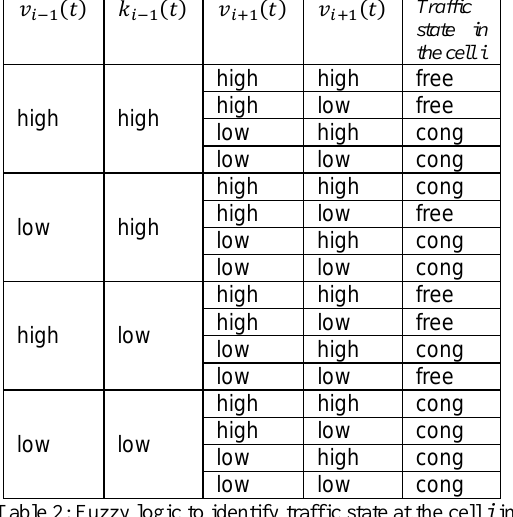
Table 2: Fuzzy logic to identify traffic state at the cell i in the time step t Figure 3: Automatically extracted traffic densities vs. mean traffic speed and traffic flow plotted for each segment. The green and red colour indicates free flow and congested traffic states. The lines show the averaged trend for the two traffic